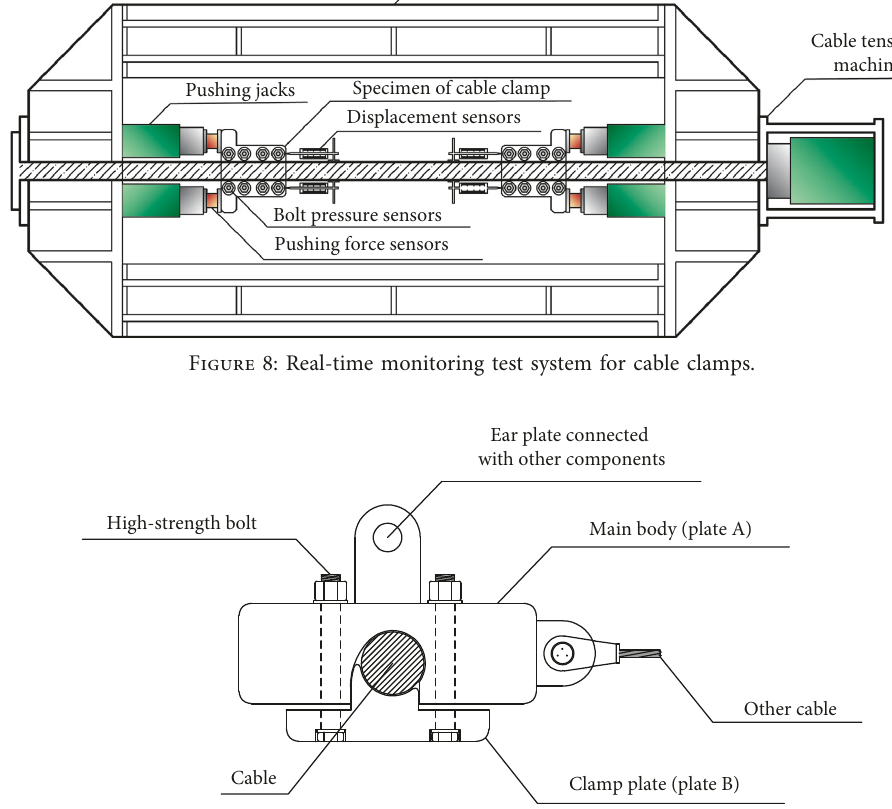
Figure 9: The composition of a cable clamp.